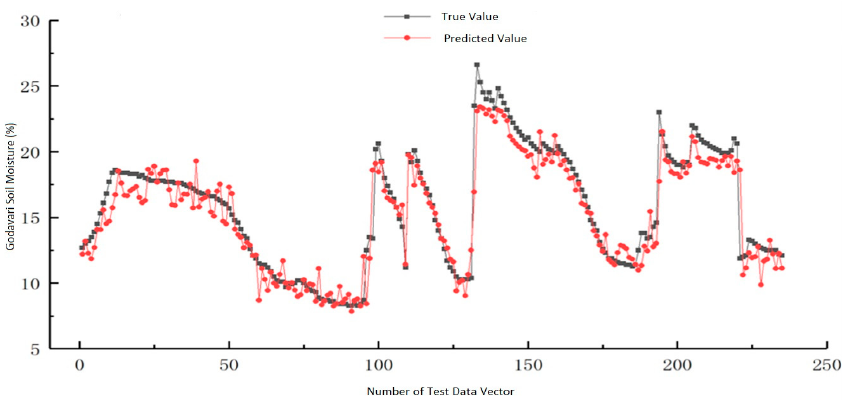
Figure 10. Forecast of testing data—Krishna Soil Moisture Dataset.